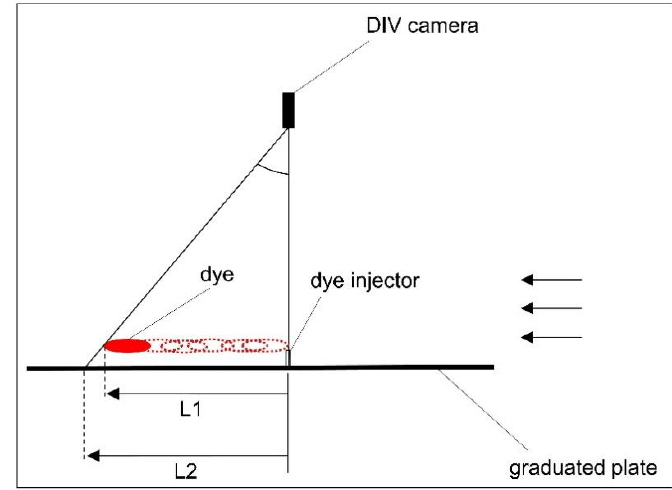
Figure 6. Actual distance travelled by the dye vs. the DIV camera estimation.